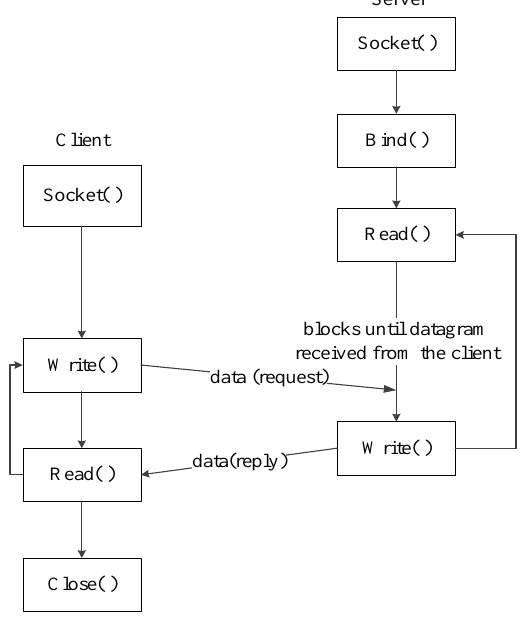
Figure 2. Datagram-oriented sockets interaction.